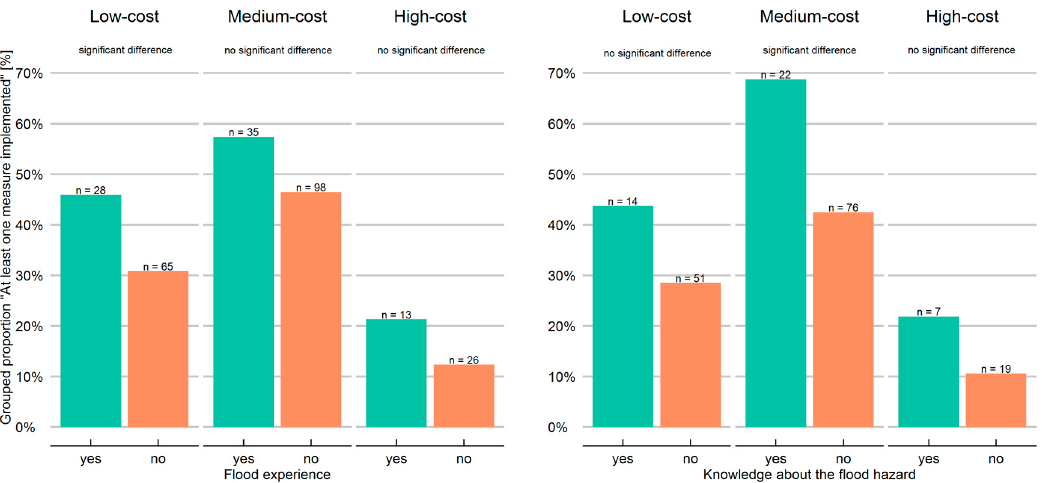
Figure 3. Percentage of households that implemented at least one precautionary measure split by flood experience and knowledge about the flood hazard for different cost levels.